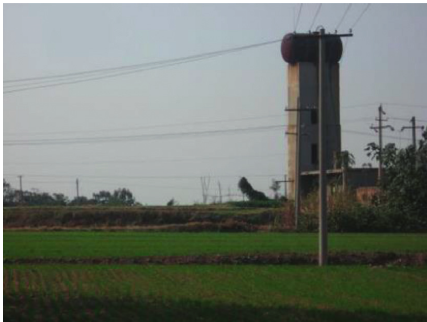
Figure 1: Rural water tower (the picture comes from https://image.